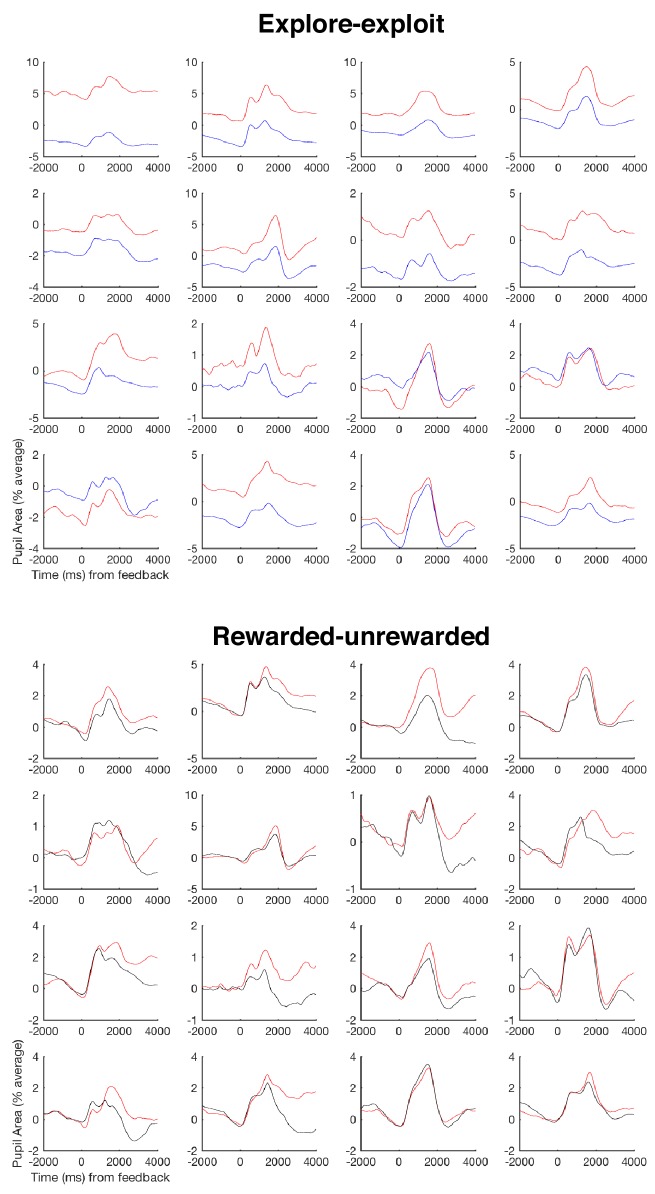
Individual pupil effects.Here we show – as requested by a reviewer – individual pupil effects, since pupil effects are prone to strong individual differences. We present the mean timecourse for each participant for both of the two pupil effects presented in Figure 3a, namely splitting by exploit (red trace) and explore (blue trace) trials, and splitting by rewarded (red trace) and unrewarded (black trace) trials. Each panel denotes the effect for each of the 16 participants that entered the pupil analyses in Figure 3. Notations are the same as in Figure 3a.